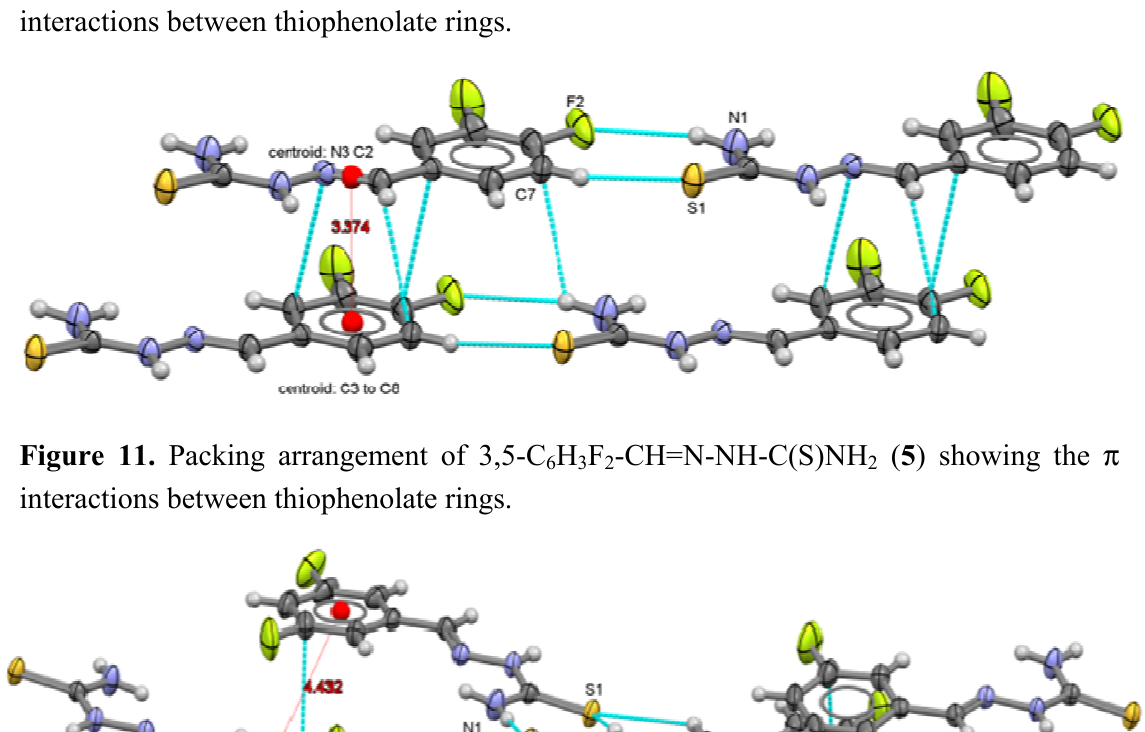
H F -CH=N-NH-C(S)NH 6 3 2